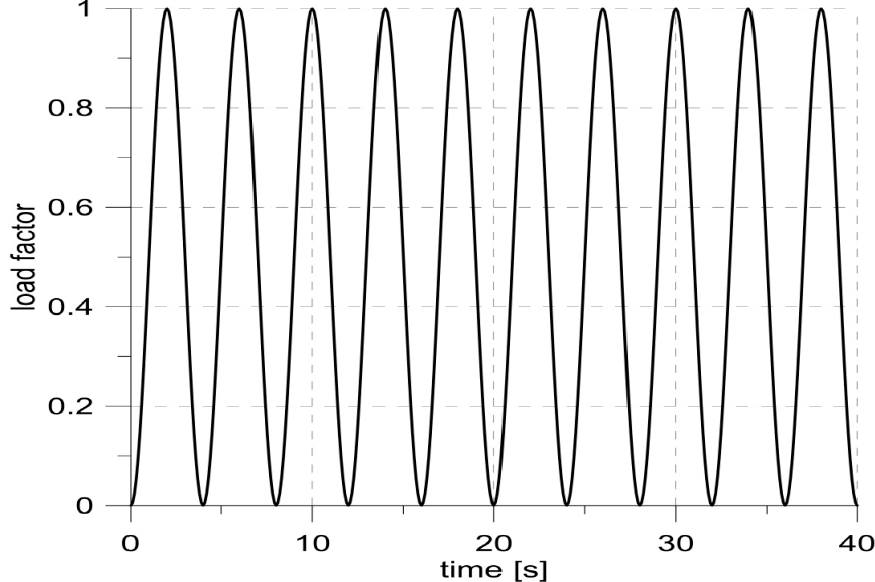
Figure 3 . Changes in the load factor describing the amplitude of the loads regarding the maximum